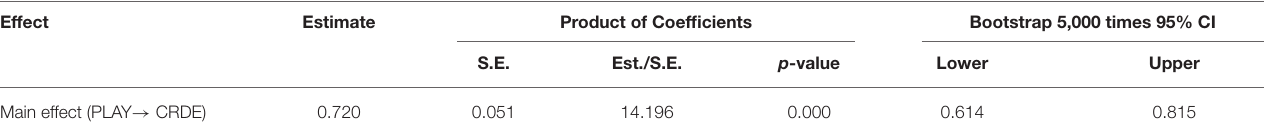
TABLE 9 | Main effect test